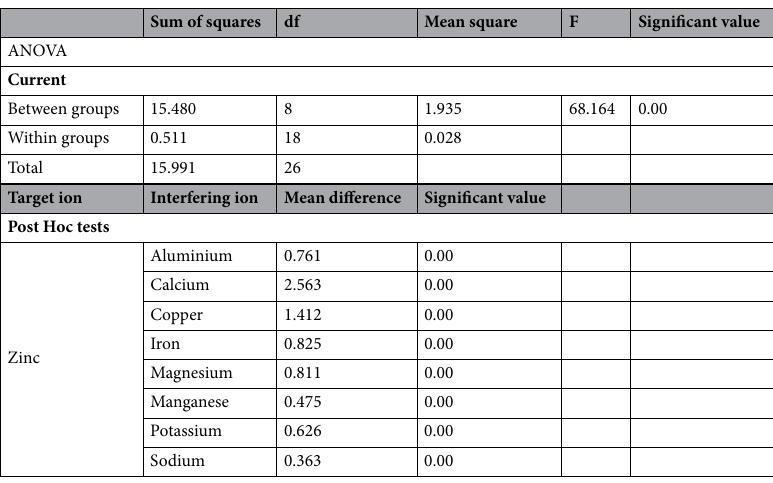
Table 4. The One-Way ANOVA analysis of zinc ion in the presence of interfering ions.